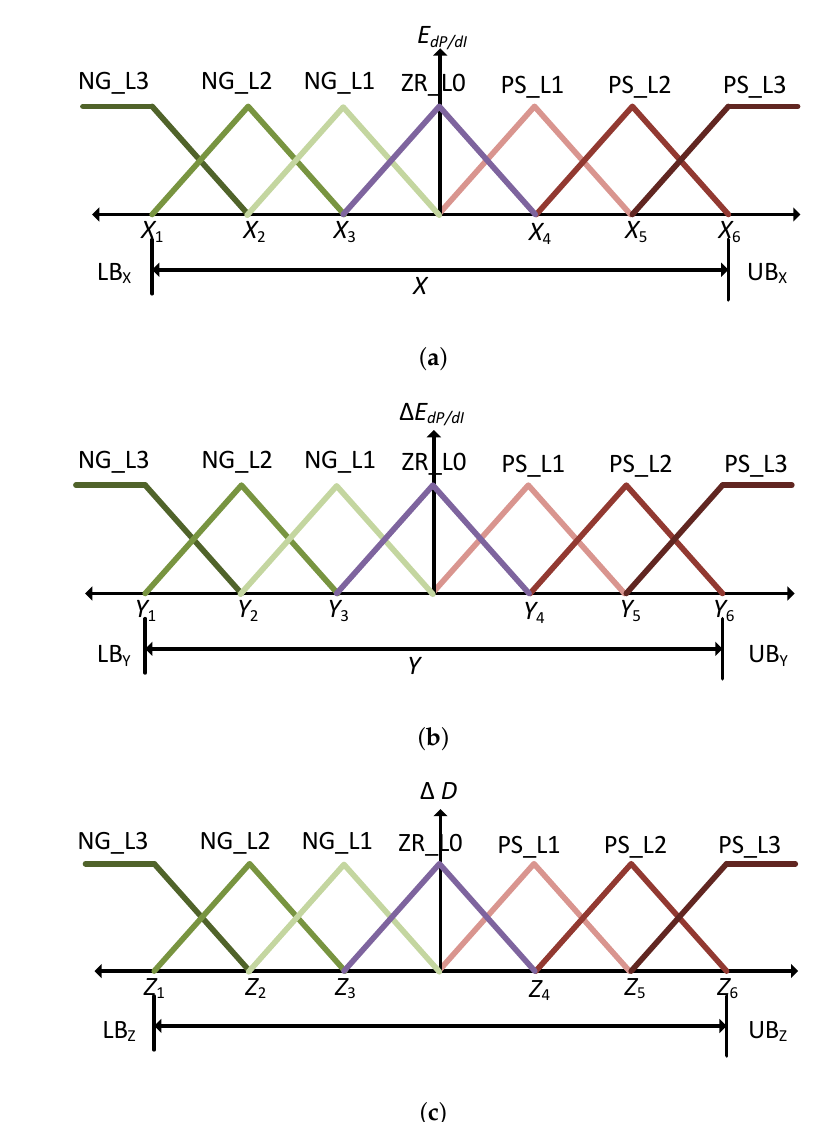
Figure 7. The implementation of the proposed FLC MPPT structure and its main components.